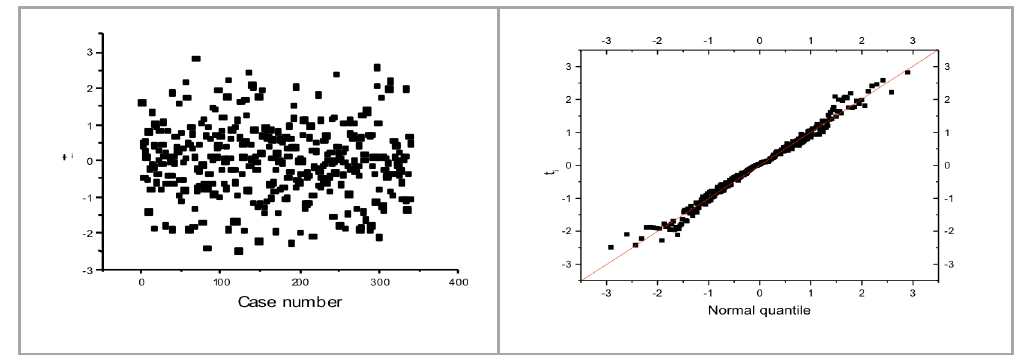
Employees’ appraisal data with random rater effect fit: scatter plots of residuals and normal probability plots